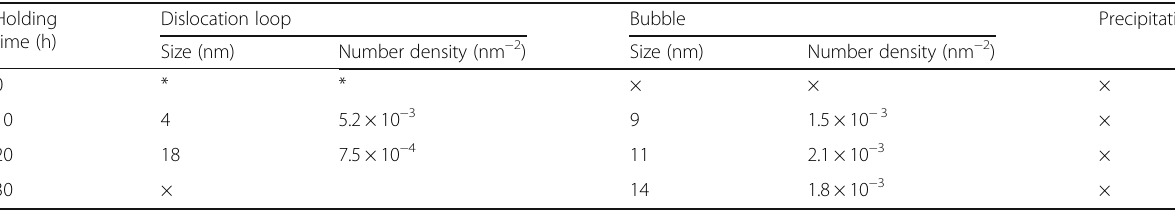
Table 2 Quantitative analysis of irradiation-induced defects Holding time